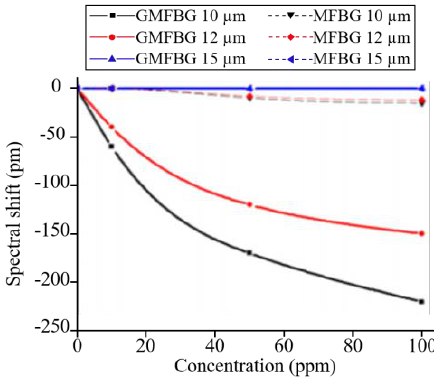
Figure 10. Spectral shifts of the GMFBGs and MFBGs for different concentrations of NH 3 . Reprinted with permission from [116].